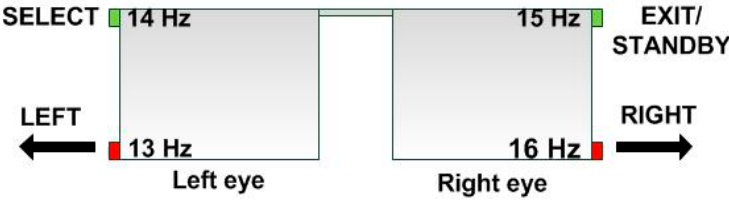
Figure 6. Location of four flickering LEDs at the dichroic infrared mirrors and possible meaning in a specific